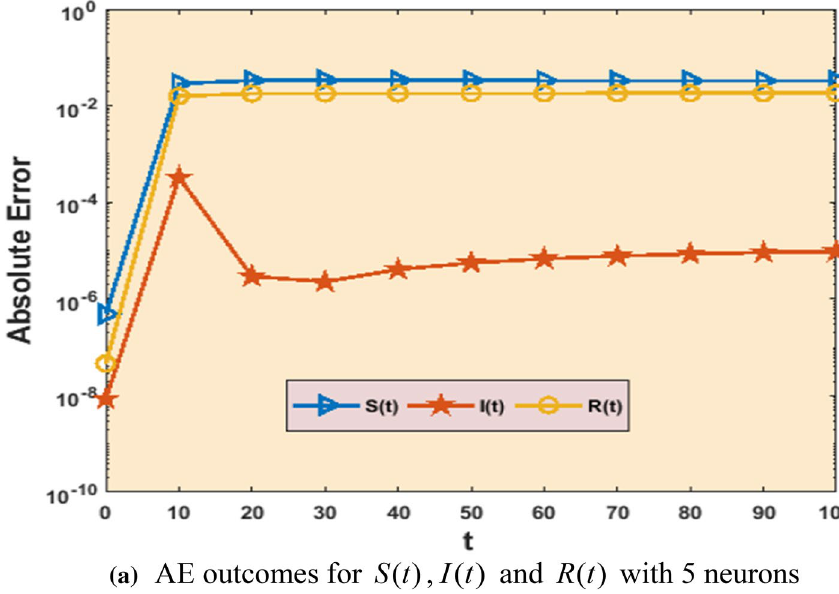
Fig. 3 Analysis about absolute error outcomes for five numbers of